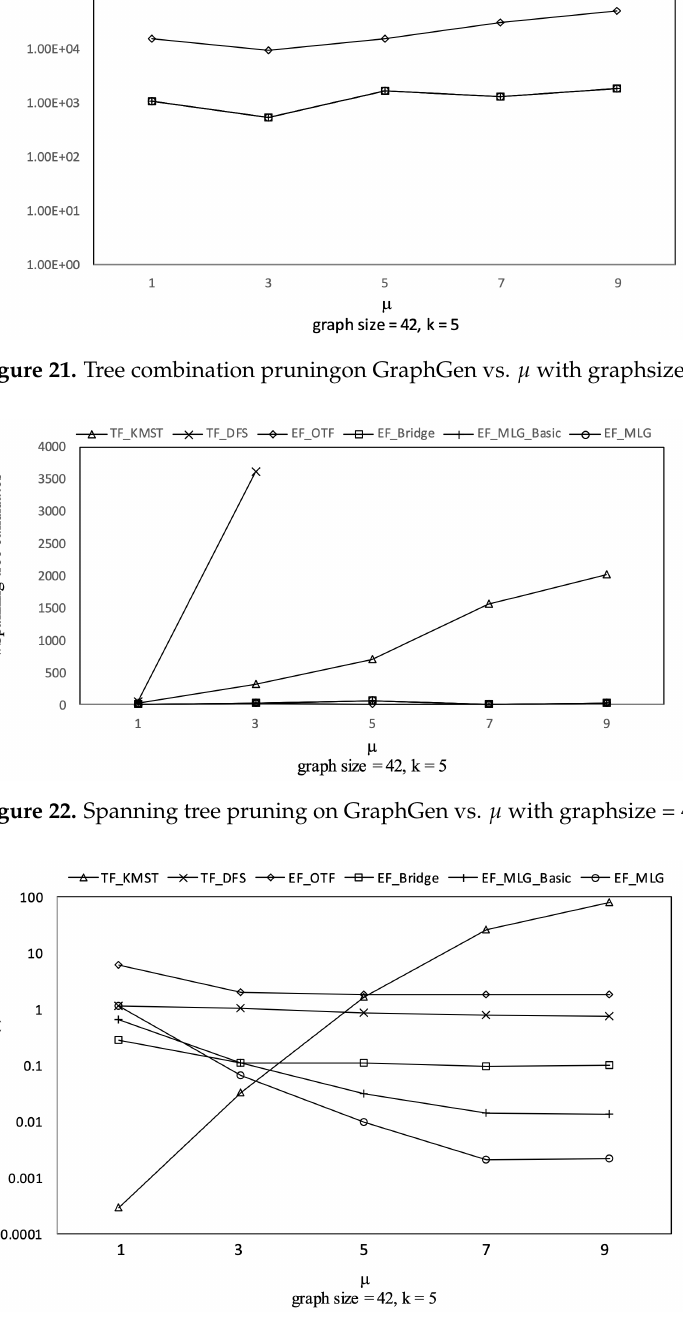
Figure 23. Runtime on GraphGen vs. µ with graphsize = 42 and k =